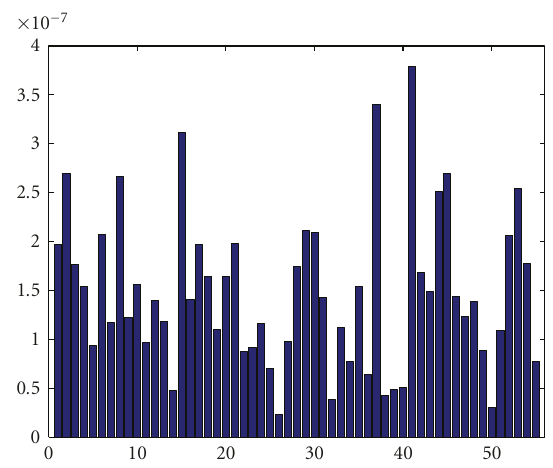
Figure 4: Distribution of powers after